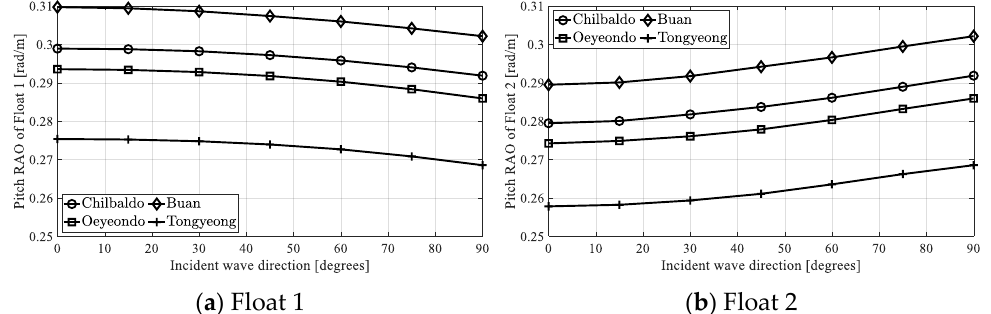
Figure 18. Comparison of the pitch RAO according to the incident wave directions at each location.